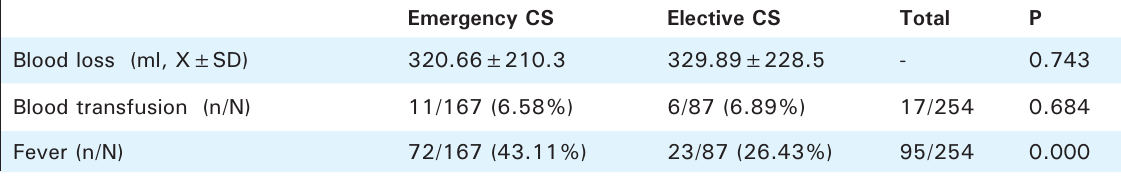
Table 3. Trend of complications in Emergency Vs Elective